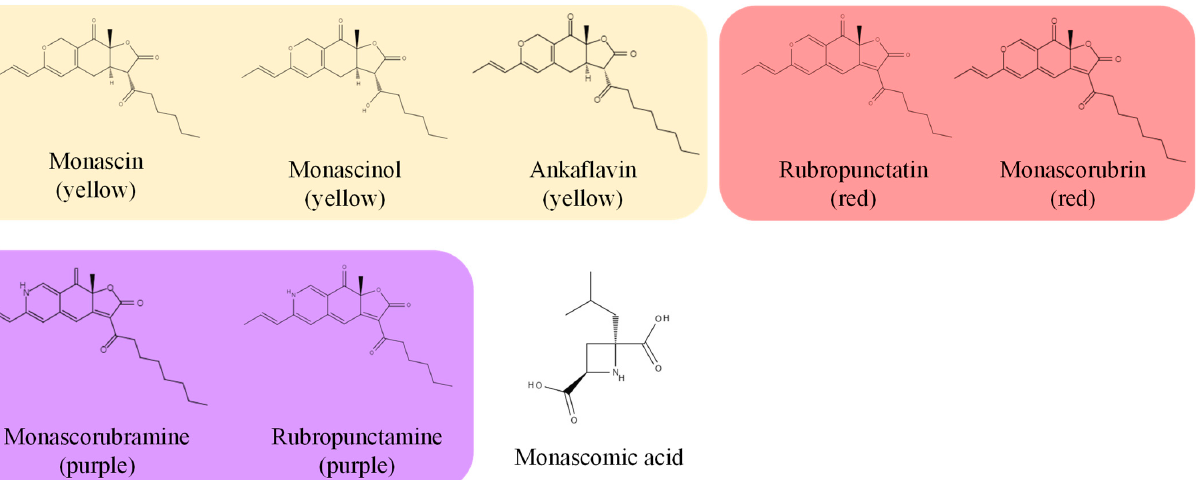
Figure 6. Monacolins (polyketides) produced by Monascus fungi. Figure 7. Lactone and acid forms of monacolin K.